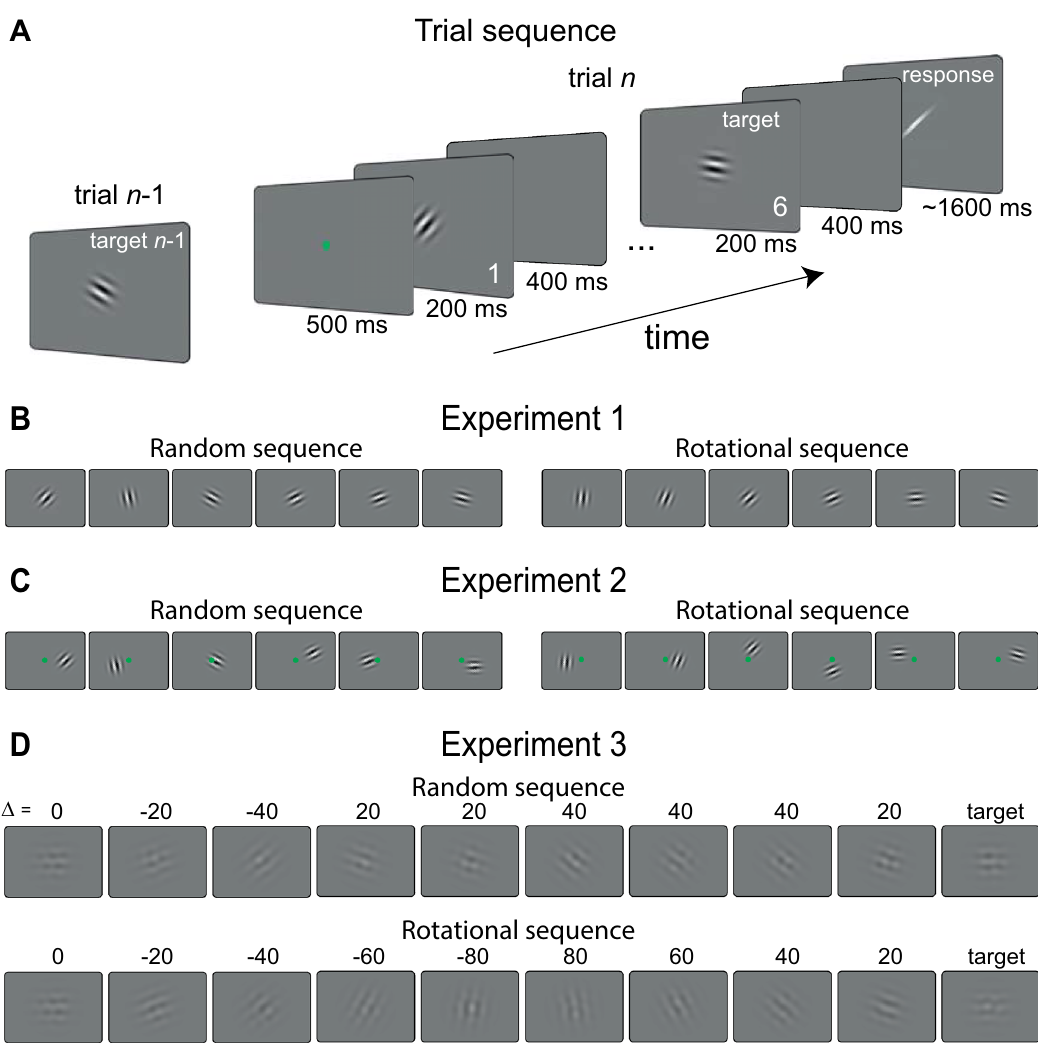
Figure 1. ( A ) Example of a trial sequence. On each trial, participants were presented with a sequence of oriented Gabors and reproduced the orientation of the last one by adjusting a response bar. ( B ) The two conditions of Experiment 1, with stimuli presented at fovea. In separate blocks of trials, the orientation sequence unfolded either randomly or following a rotational momentum (here a clockwise rotation). ( C ) In Experiment 2, stimuli were presented at random locations within ± 3° off fixation. ( D ) In Experiment 3, longer sequences (from 4 to 12) of low-contrast and noisy Gabor stimuli were used. The Random sequences were designed to yield stronger adaptational bias than the Rotational condition (e.g., more Gabors tilted in the same direction relative to the target, here clockwise, Δ = 20°–40°). The green fixation spot was presented at the beginning of each sequence in Experiment 1 and 3 and remained on screen for the entire sequence in Experiment 2. Stimuli are not drawn to